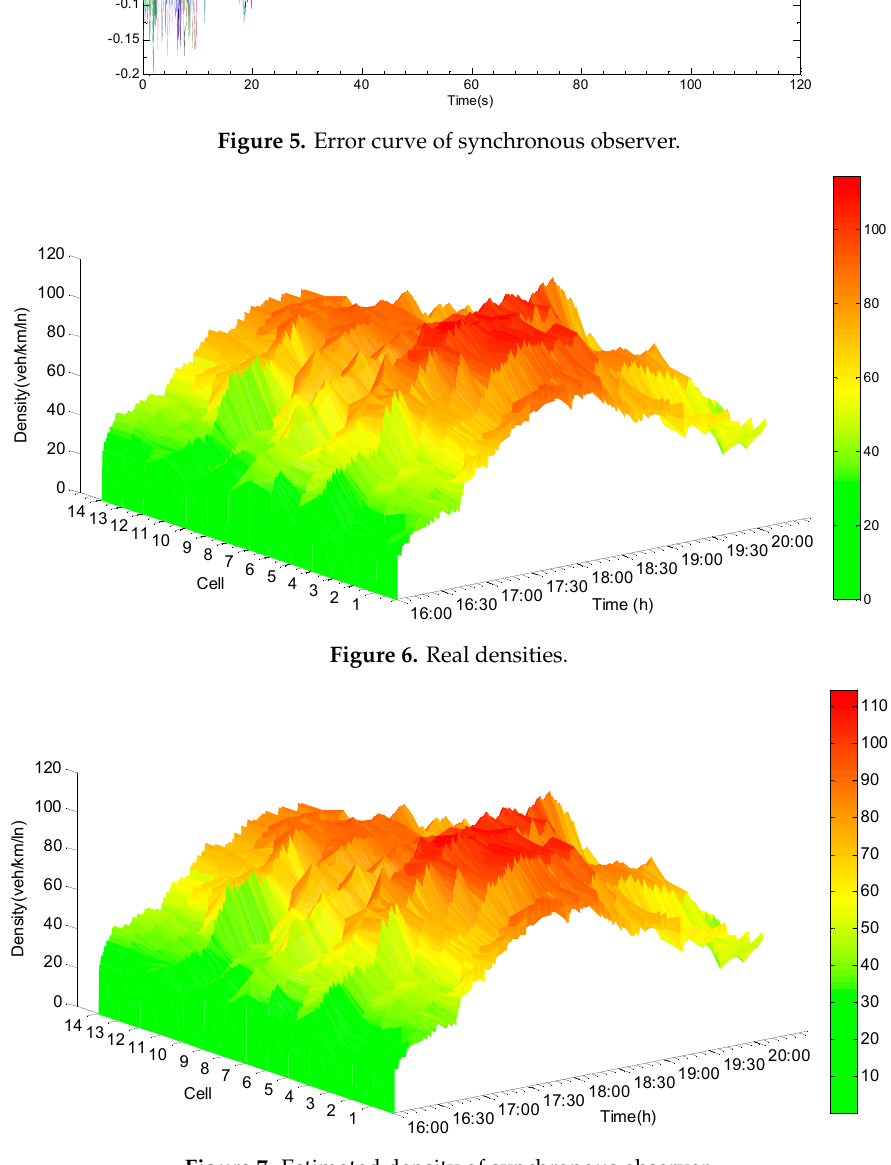
Figure 7. Estimated density of synchronous observer.